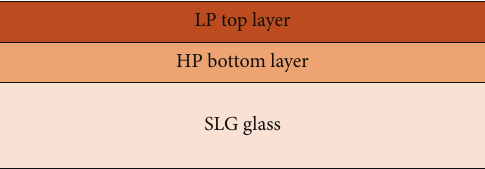
Figure 1: Schematic of the bilayer Mo rear electrode design. The bottom Mo layer was deposited at HP ( 6.0×10 −3 mbar) while the top Mo layer was deposited at LP ( 1.5 × 10 −3 mbar). The total thickness of the bilayer Mo stacks was approximately